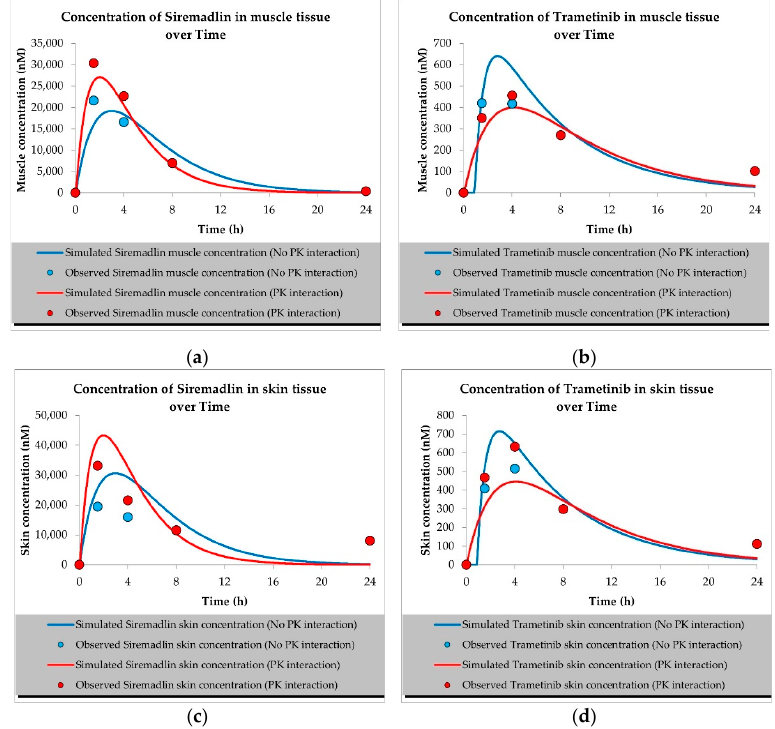
Figure 5. Values of predicted concentrations with and without PK interaction for ( a ) siremadlin and ( b ) trametinib in liver tissue; ( c ) siremadlin and ( d ) trametinib in lung tissue; observed data are means from n = 3.